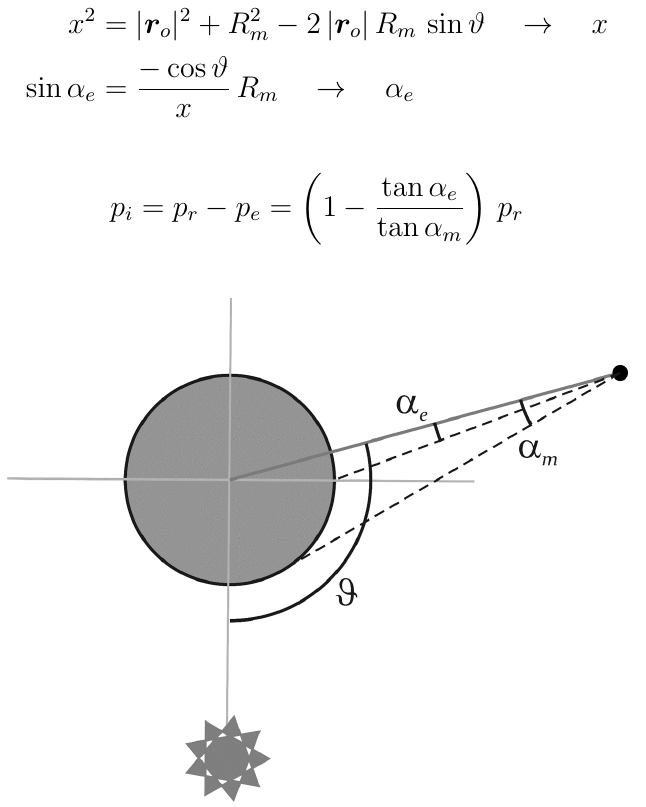
Figure 5. The crescent Moon